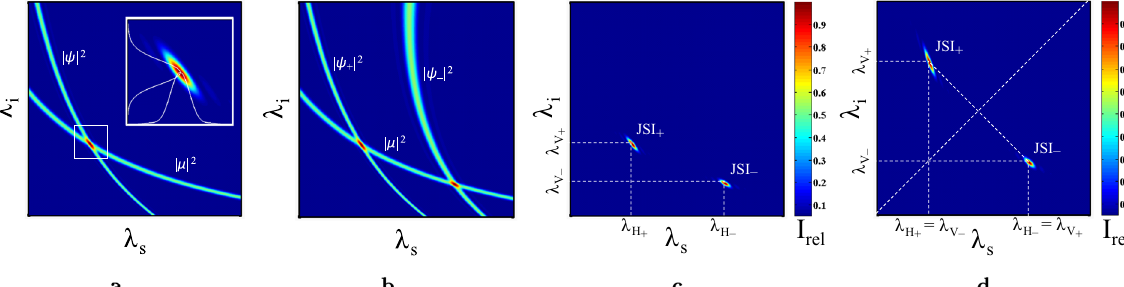
Figure 2. Depiction of the joint spectral intensity. Figure ( a ) illustrates how the intersection of the pump intensity | μ | 2 and the phase-matching intensity | ψ | 2 shapes the joint spectral intensity distribution of signal and idler. CDDC occurs in particular configurations where | μ | 2 intersects with both components of the phase- matching intensity, namely | ψ + | 2 and | ψ − | 2 , as illustrated in Figure ( b ). This means that one crystal with a given periodicity Λ , pumped by a laser with given centre wavelength λ p 0 , can evoke two sub-JSI’s, generating photons with a total of four different wavelengths, as shown in Figure ( c ). In addition, as depicted in Figure ( d ), under careful choice of the setup, the two sub-JSI’s can be composed such that the corresponding wavelengths become interchangeable, resulting in an entangled bipartite state.